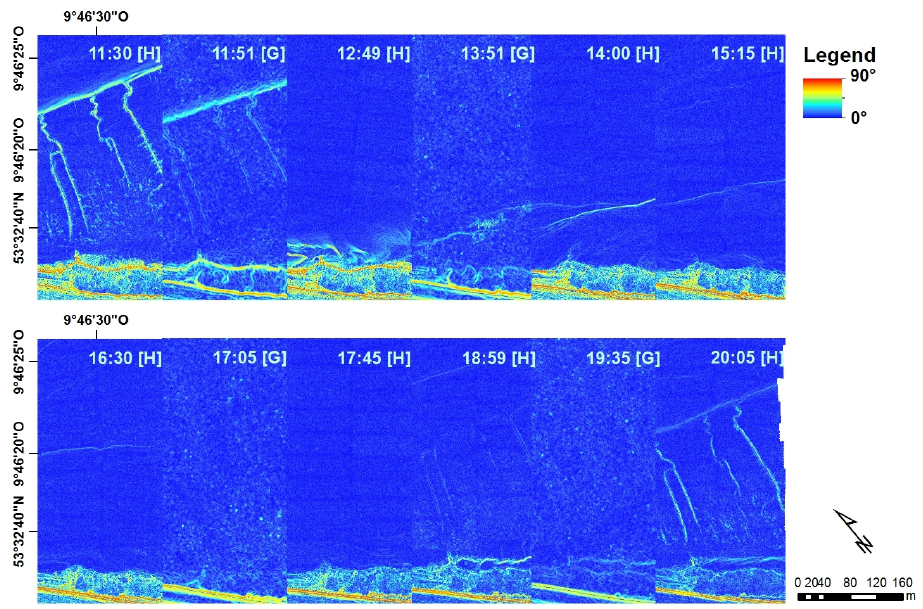
Figure 12. Detailed view of the temperature gradient in degree over the intertidal mudflats on 30.06.2015 calculated from gyrocopter [G] and hexacopter [H] data, arranged according to acquisi- tion time.